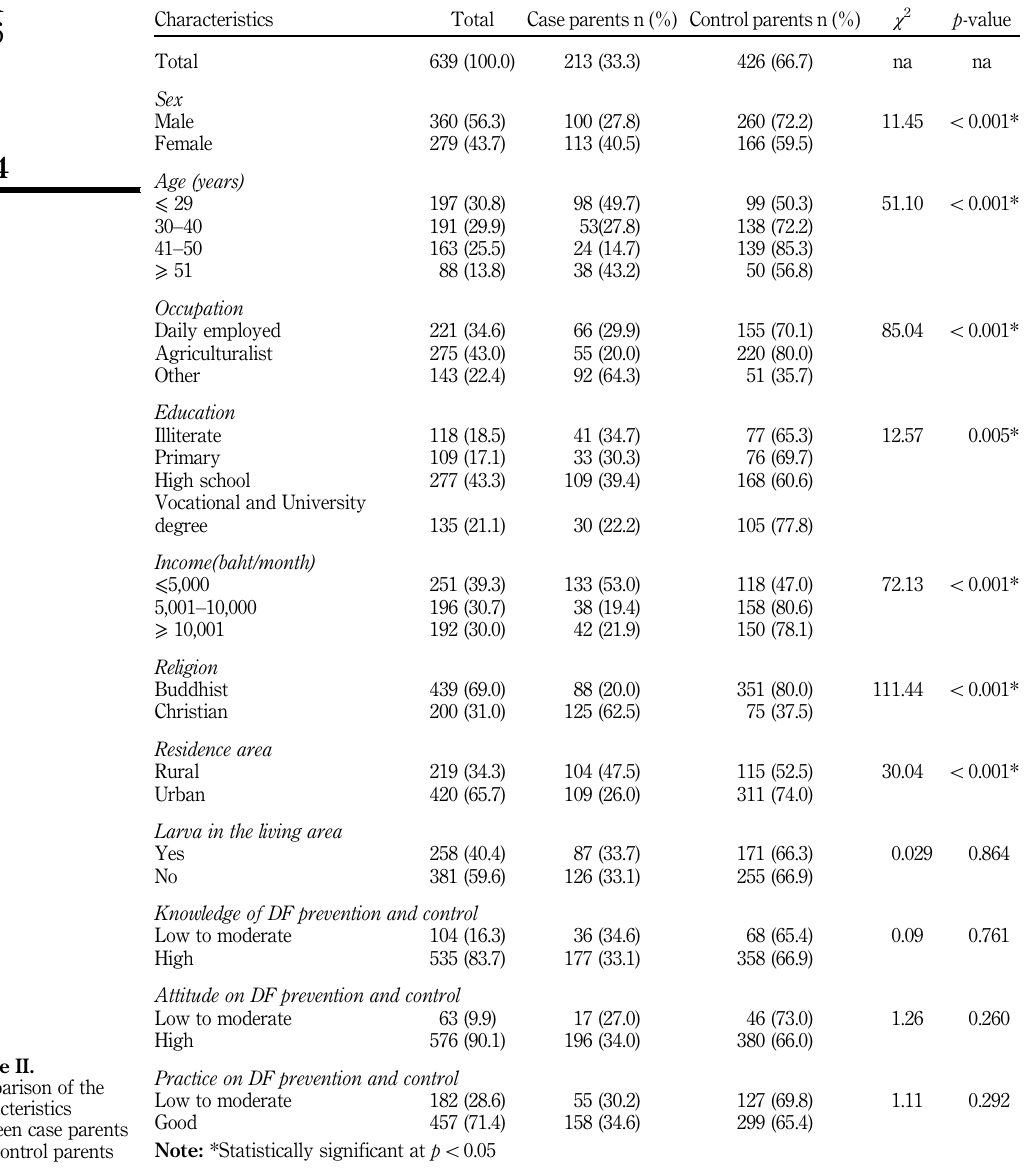
characteristics between case parents and control